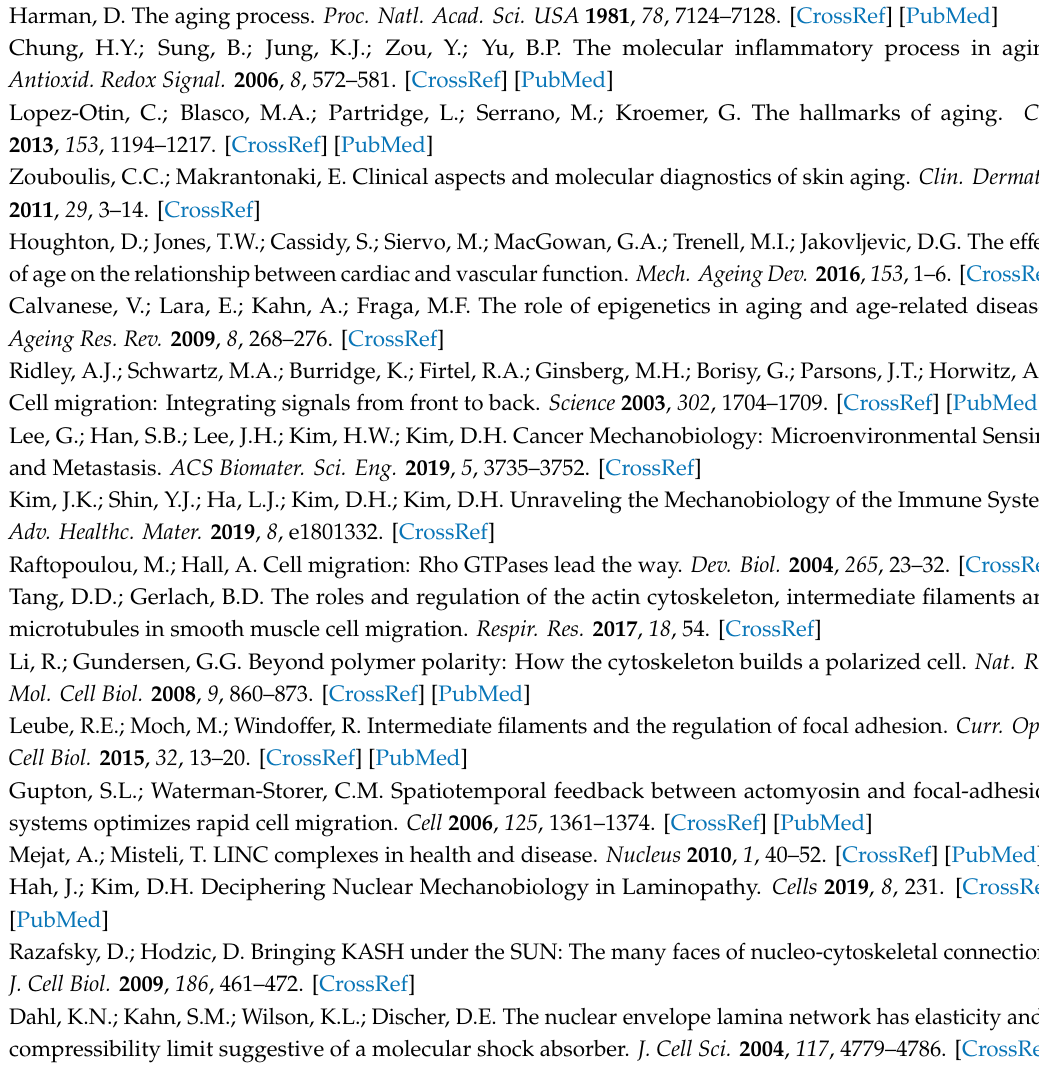
Figure S1: Age dependent changes of cell morphology. Figure S2: Age dependent changes of cell motility. Figure S3: Age dependent changes of nucleus